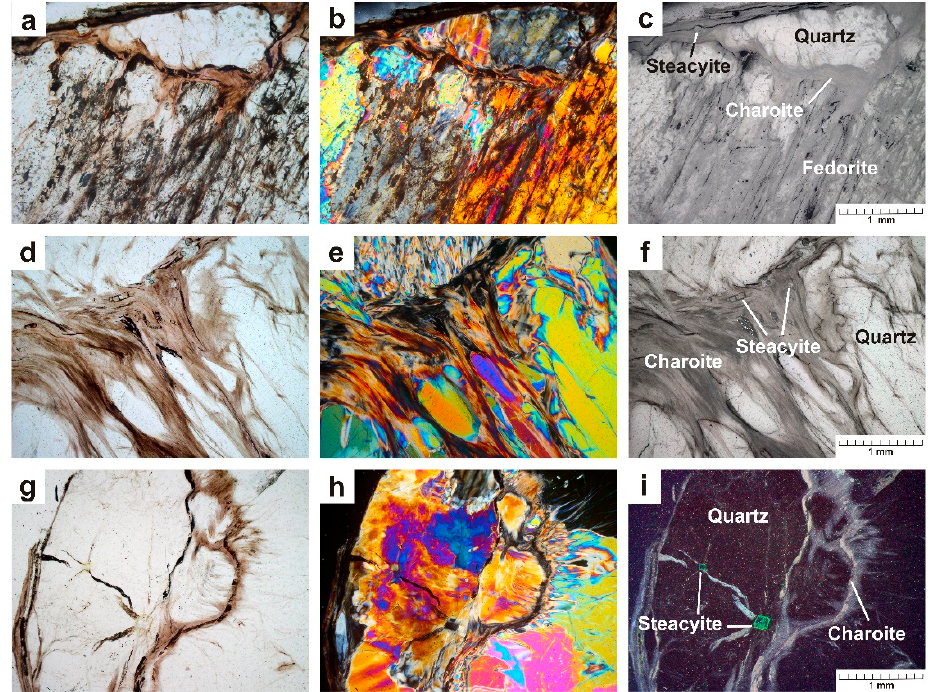
Figure 4. Polished thin section image of sample Yak-5 in transmitted ( a , b , d , e , g , h ) and reflected ( c , f ) light, and with ultraviolet radiation of 254 nm ( i ); ( a,c,d,f,g,i )—polarizers are parallel, ( b,e,h )—polarizers are crossed. The interference color corresponds to a thickness of thin section (~40 μ m).